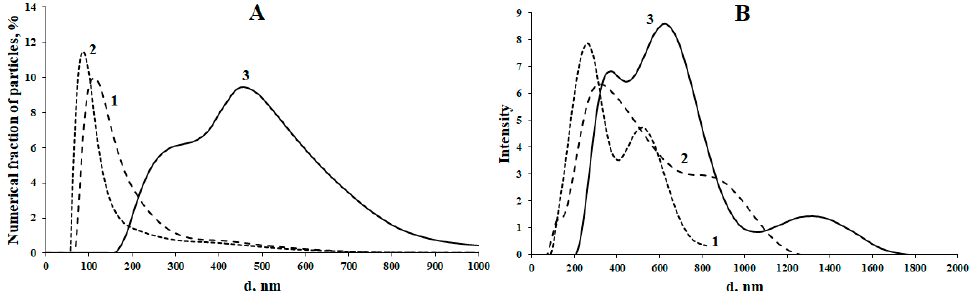
Figure 10. Number ( A ) and intensity ( B ) distributions of aggregate sizes: (1) initial amphiphilic copolymer (VP/AGE = 3); (2) after immobilization of doxorubicin; (3) after subsequent incorporation of paclitaxel.